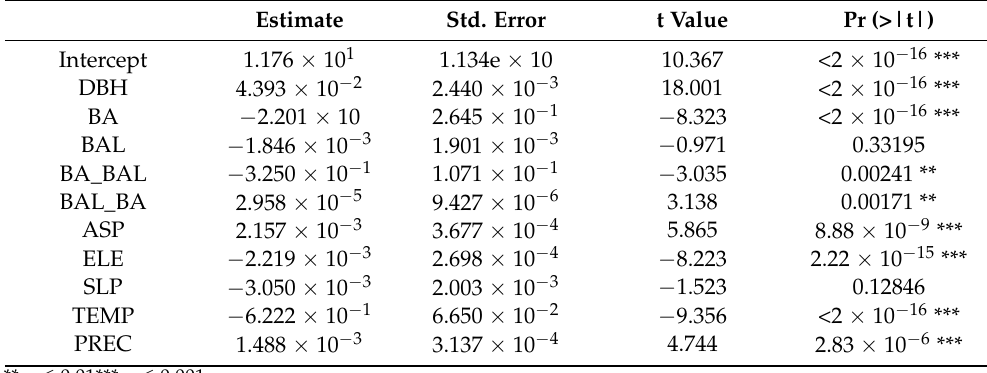
Table 7. Results of the linear mixed-effect model for diameter increment.